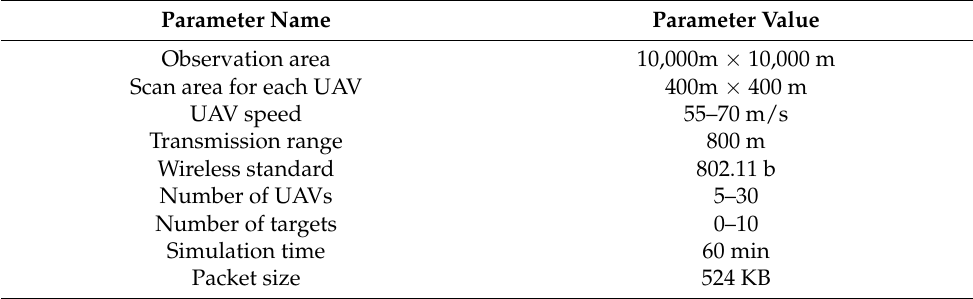
Table 2. Key parameters in the simulation experiments in Network Simulator 3.26.